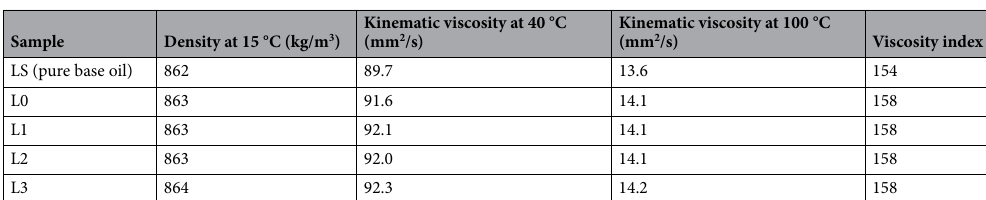
Table 3. The physicochemical properties of engine oil and TiO 2 nanolubricants.